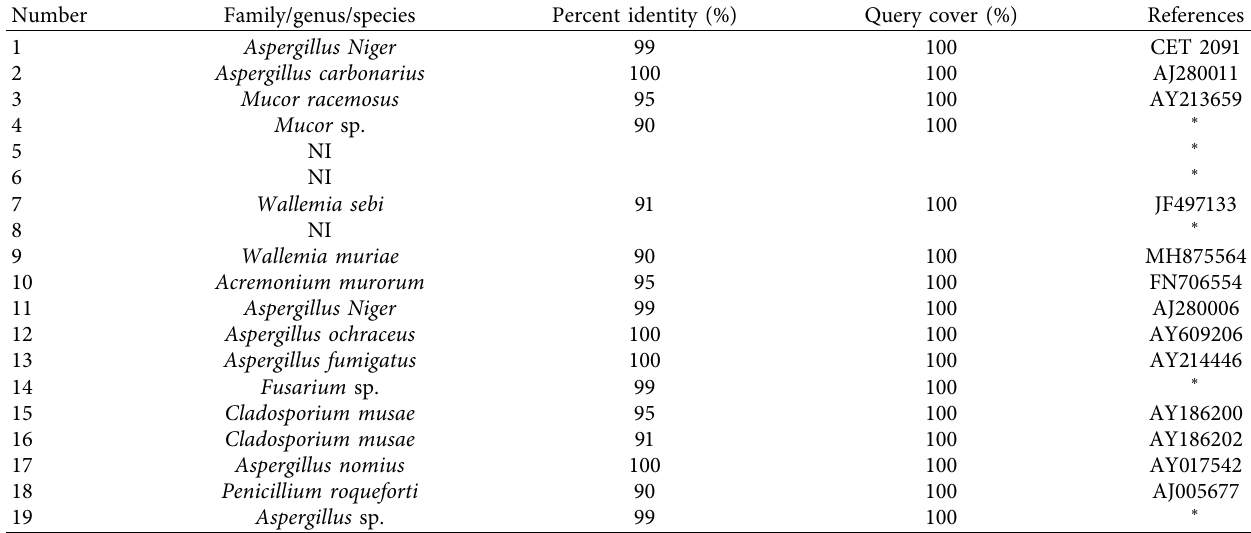
Figure 2: DGGE profiles of PCR amplicons of the domain D1 of 28S rDNA that represent the fungi biodiversity in of coffee. Markers (1, 2); Bfss: Bafoussam; Dsch: Dschang; Baf: Bafia; Bat: Batouri. The position of bands is indicated by numbers that correspond to species of Table 2: Identification of fungal DNA bands excised from DGGE gels.